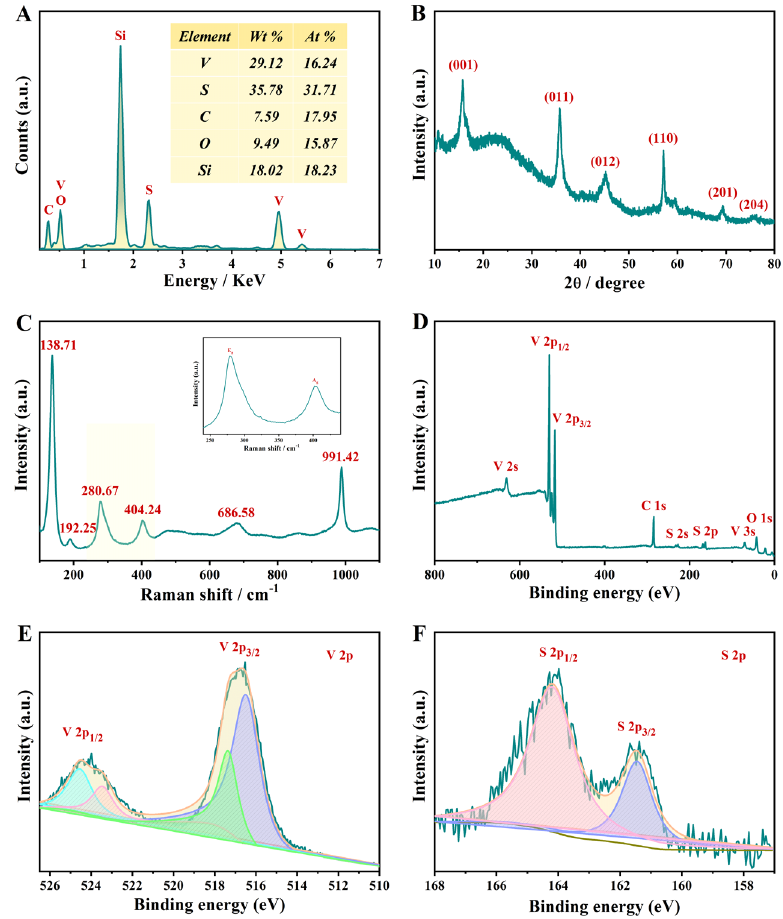
Figure 2. Characterization of VS 2 nanosheets: ( A ) EDS; ( B ) XRD; ( C ) Raman; ( D ) XPS. ( E , F ) show the amplified V 2p and S 2p zone in XPS.